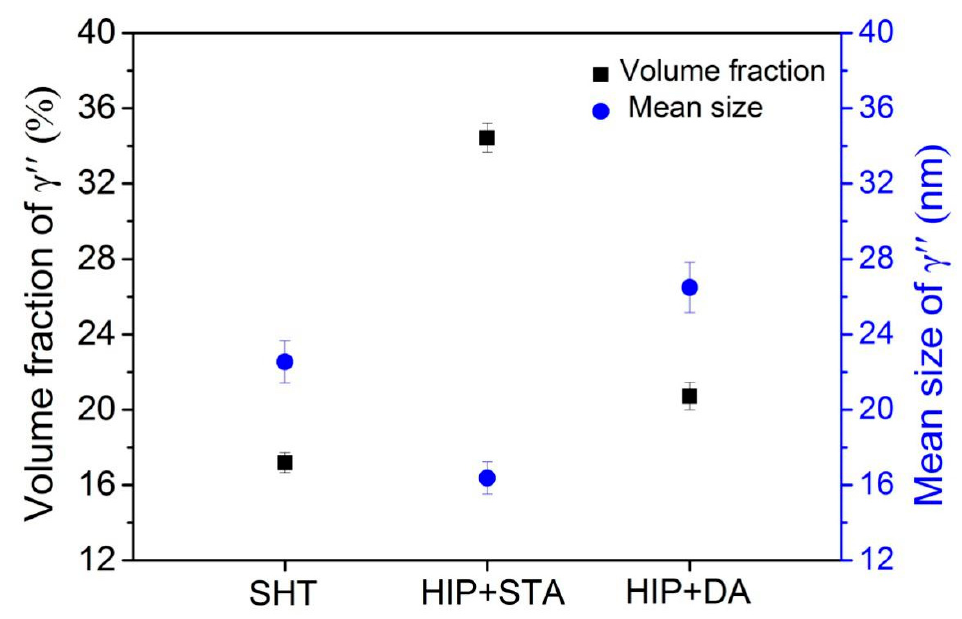
Figure 5. Volume fractions and mean sizes of γ ” precipitates in the SHT, HIP + STA, and HIP + DA Inconel 718 superalloys.